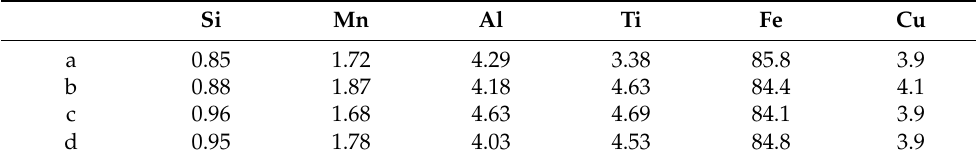
Figure 1. SEM micrograph of weld metal analysed areas ( × 1500). Table 4. SEM-EDS analyses of marked areas in Figure 1 (mass%).